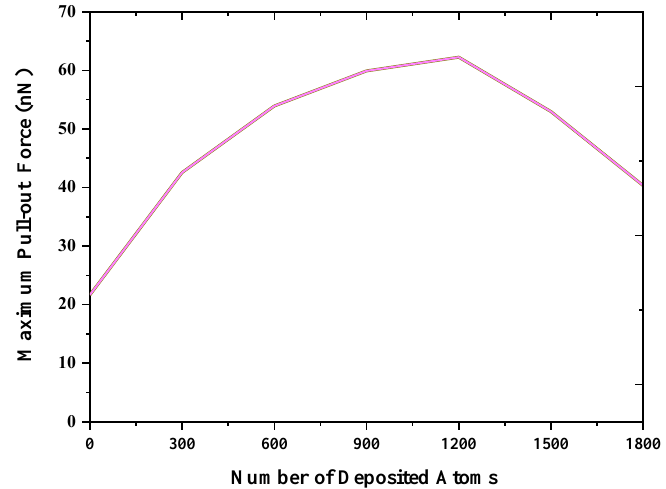
Figure 6. The maximum pull-out force changes as a function of the number of deposited copper atoms for the graphene/Cu composite.